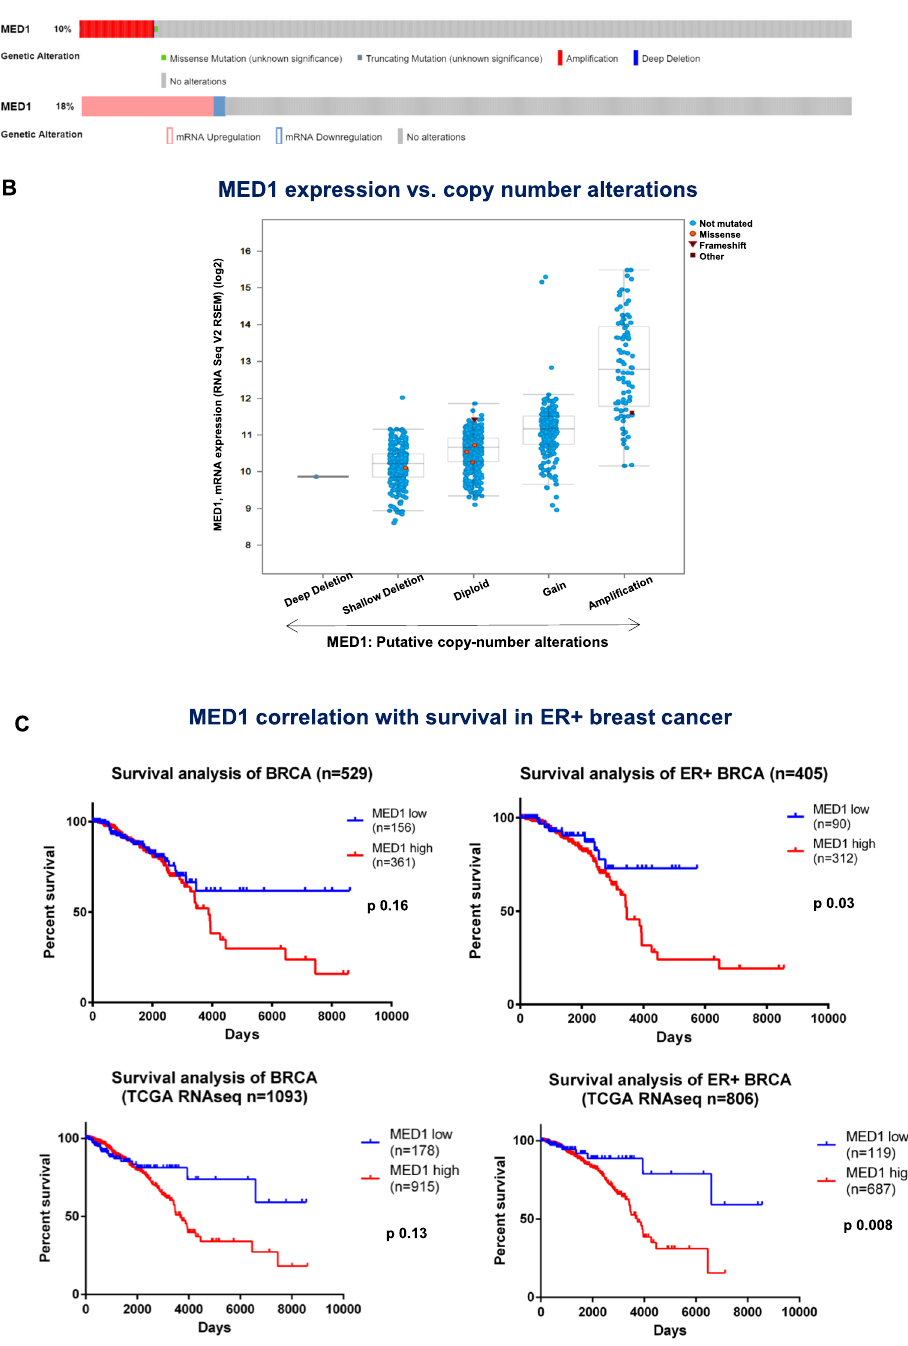
Figure 1. MED1 alterations in breast cancer patients. ( A , B ) Genetic and transcriptomic alterations of MED1 in breast cancer patients. MED1 copy number variations and expression alterations were found in breast cancer patients from TCGA database ( A ). Copy number variations of MED1 locus are correlated to variations in MED1 mRNA expression levels ( B ). ( C ) MED1 expression is significantly associated to survival in breast cancer patients. Survival data were obtained from TCGA data portal for two datasets of BC patients analysed with microarray (top graphs) or RNA sequencing (bottom graphs). Both datasets confirmed a significant positive association between MED1 expression and Overall Survival in ER + BC